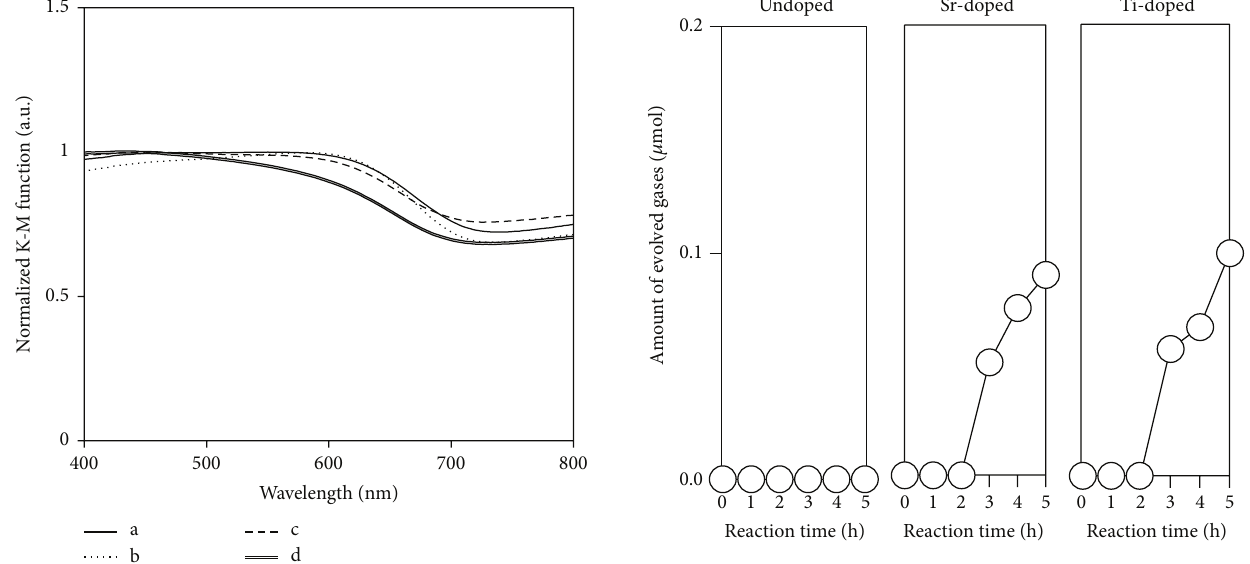
Figure 5: Time course of hydrogen evolution from an aque- ous methanol solution over undoped, Sr-doped, and Ti-doped LaNbON 2 synthesized by ammonothermal reactions with 1wt.% Pt cocatalyst loading under visible light ( 𝜆 > 380